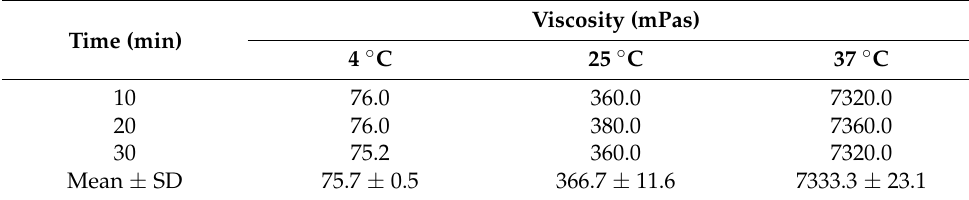
Table 3. Viscosity of the Pluronic ® F127 hydrogel at different temperatures.